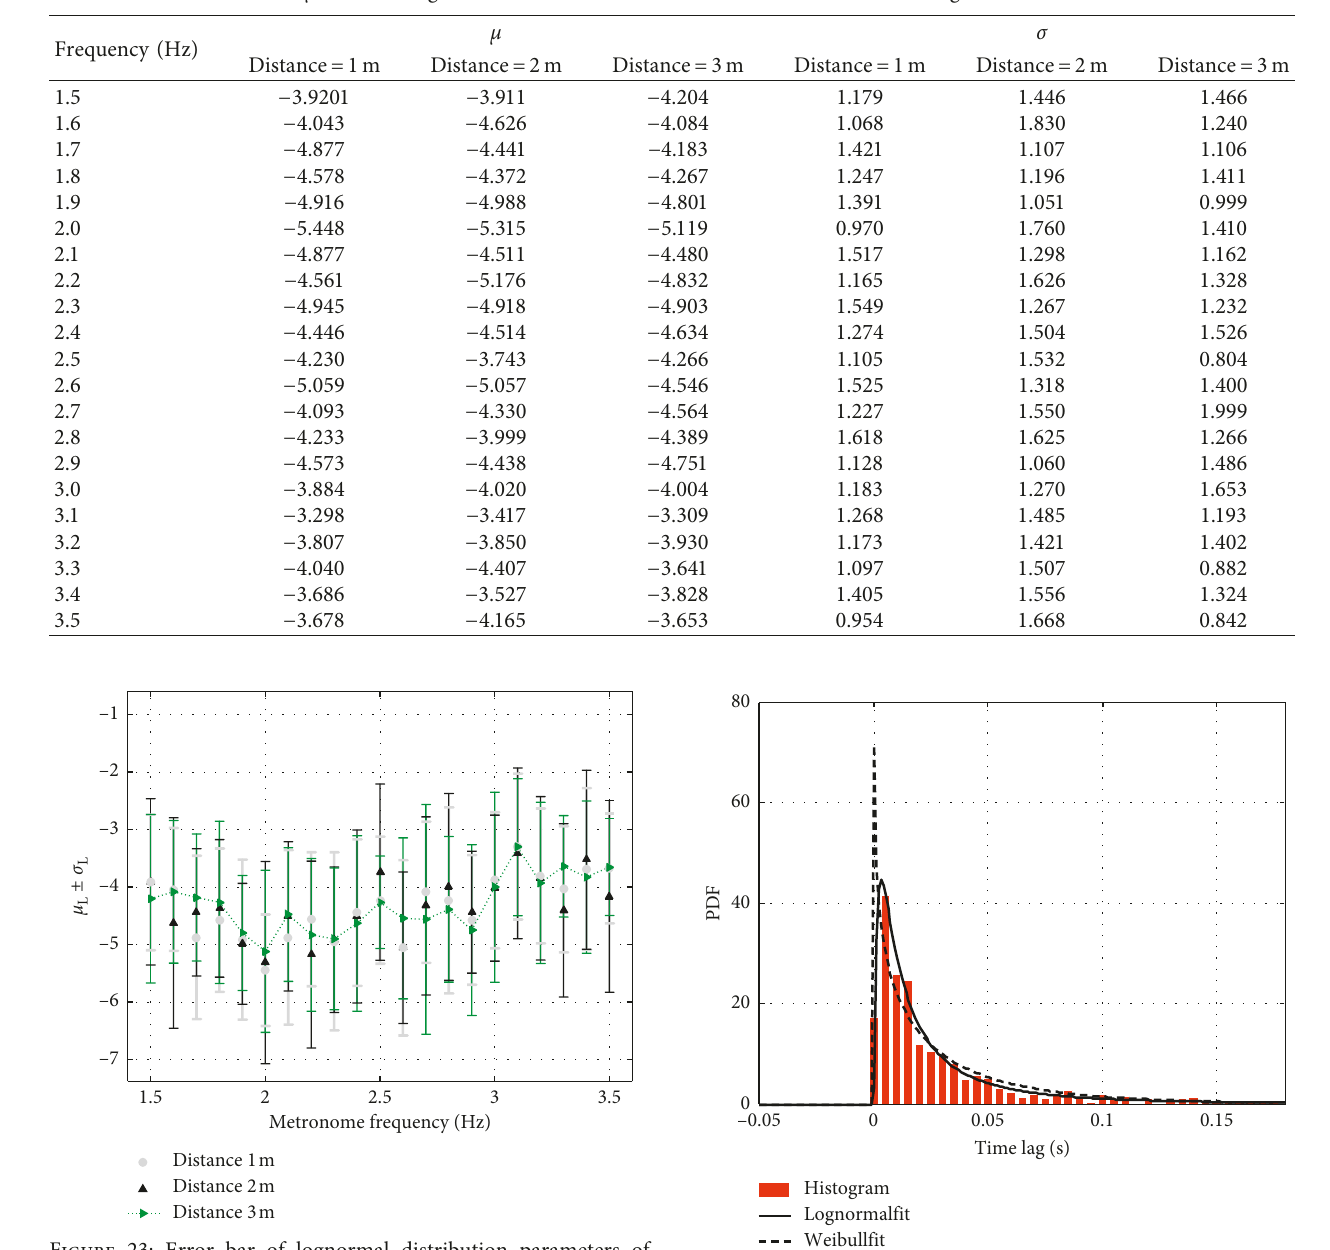
Table 5: μ and σ in lognormal distribution of coherence coefficients in the longitudinal direction.